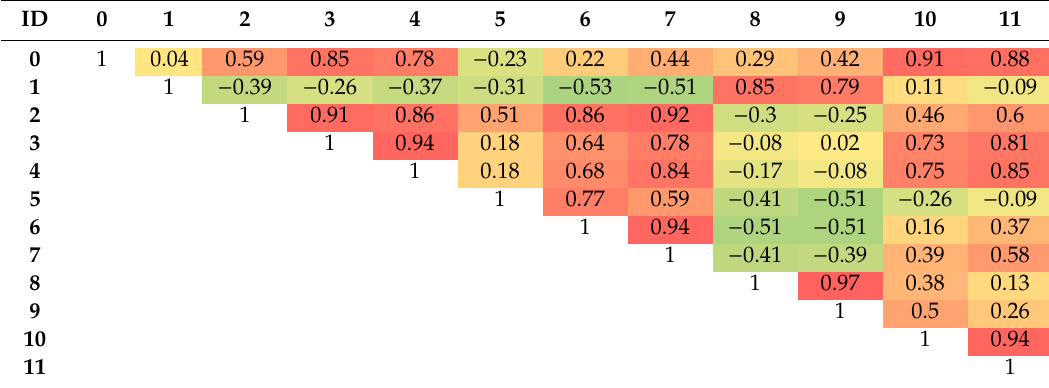
Table 3. Correlation table at study points on Kodiak and Cook Inlet from the H11